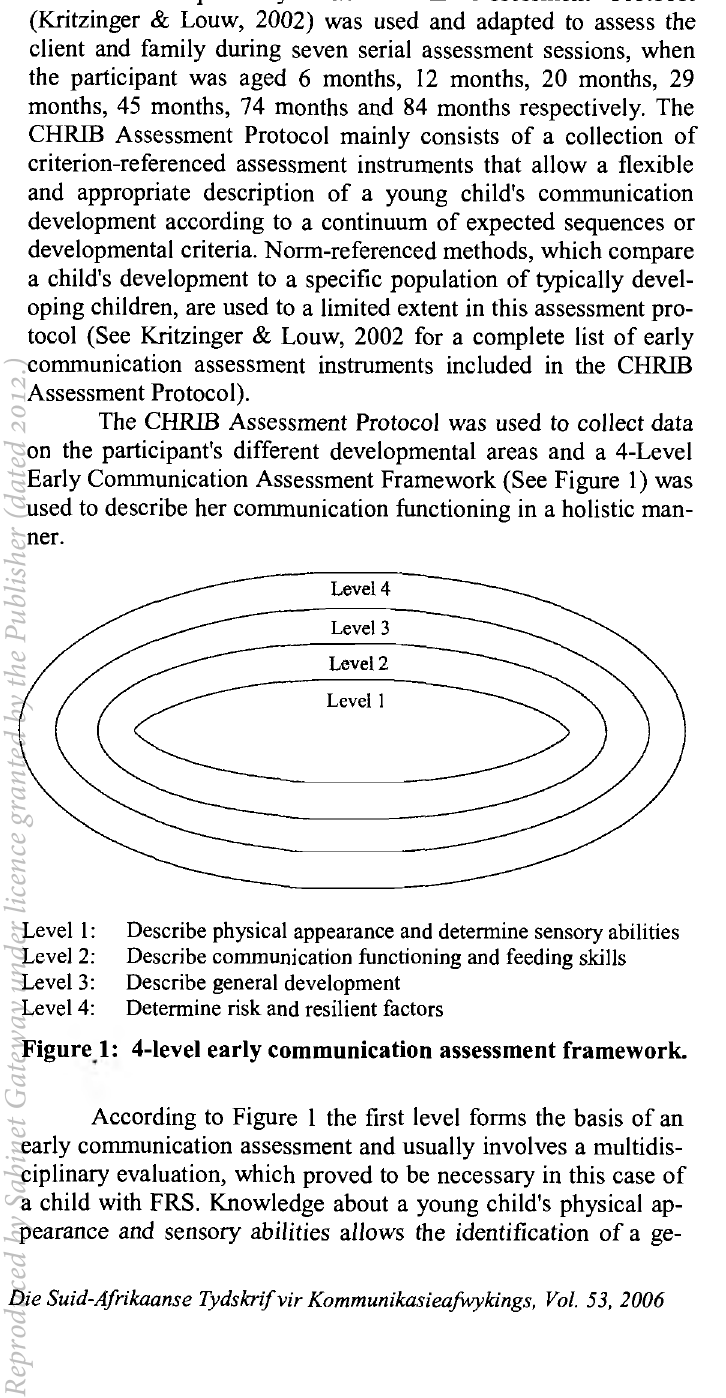
Figure 1: 4-level early communication assessment